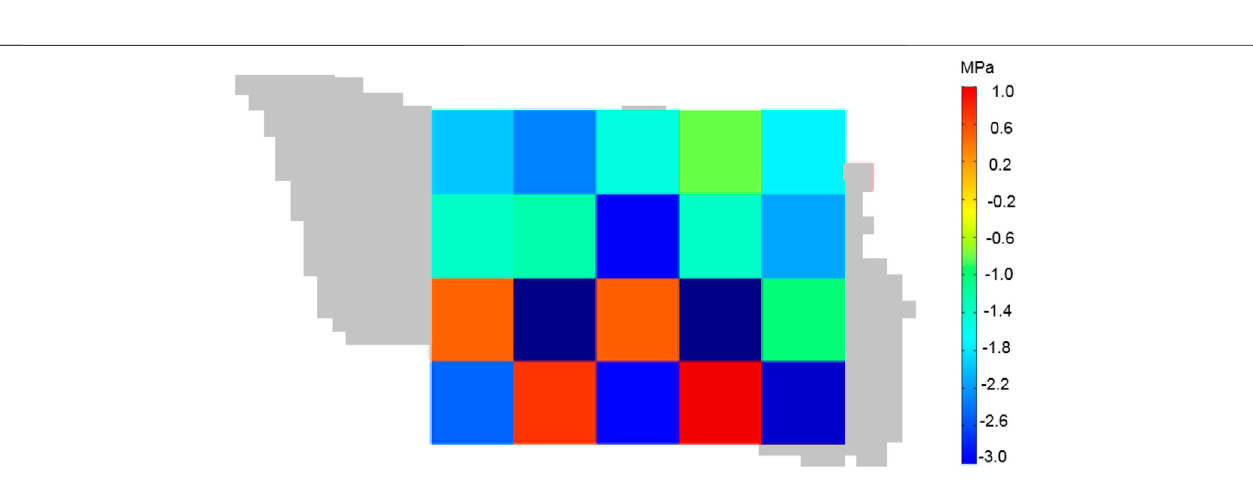
Frontiers in Earth Science |